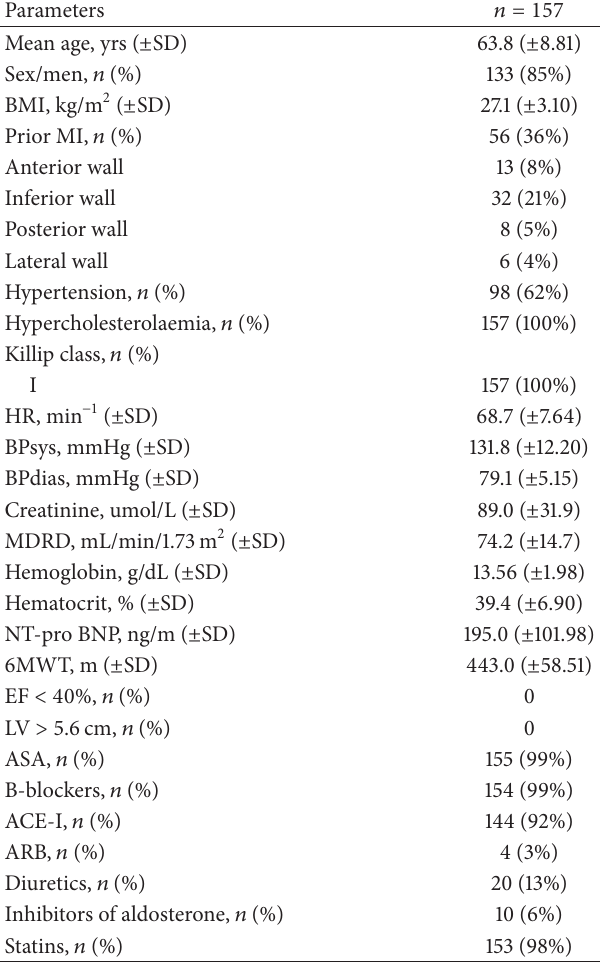
Table 2: Baseline patients